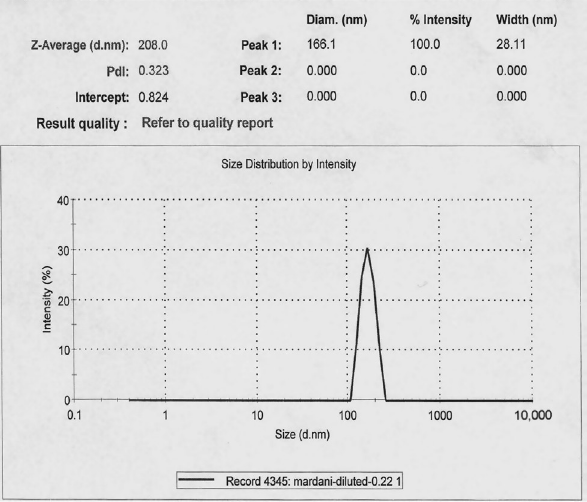
Figure 6 Particle size analysis of nanoparticles (NPs) produced after 24 h biotransformation.